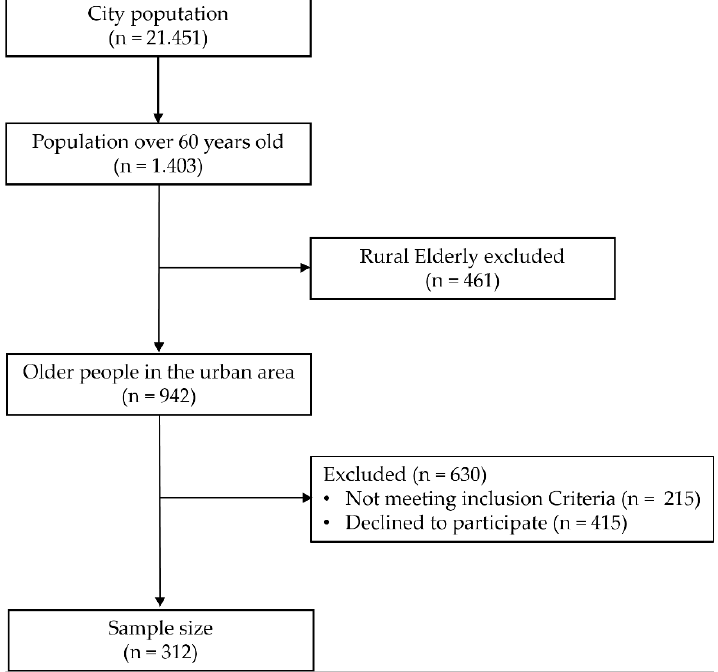
Figure 1. Flowchart diagram of the participant recruitment process.